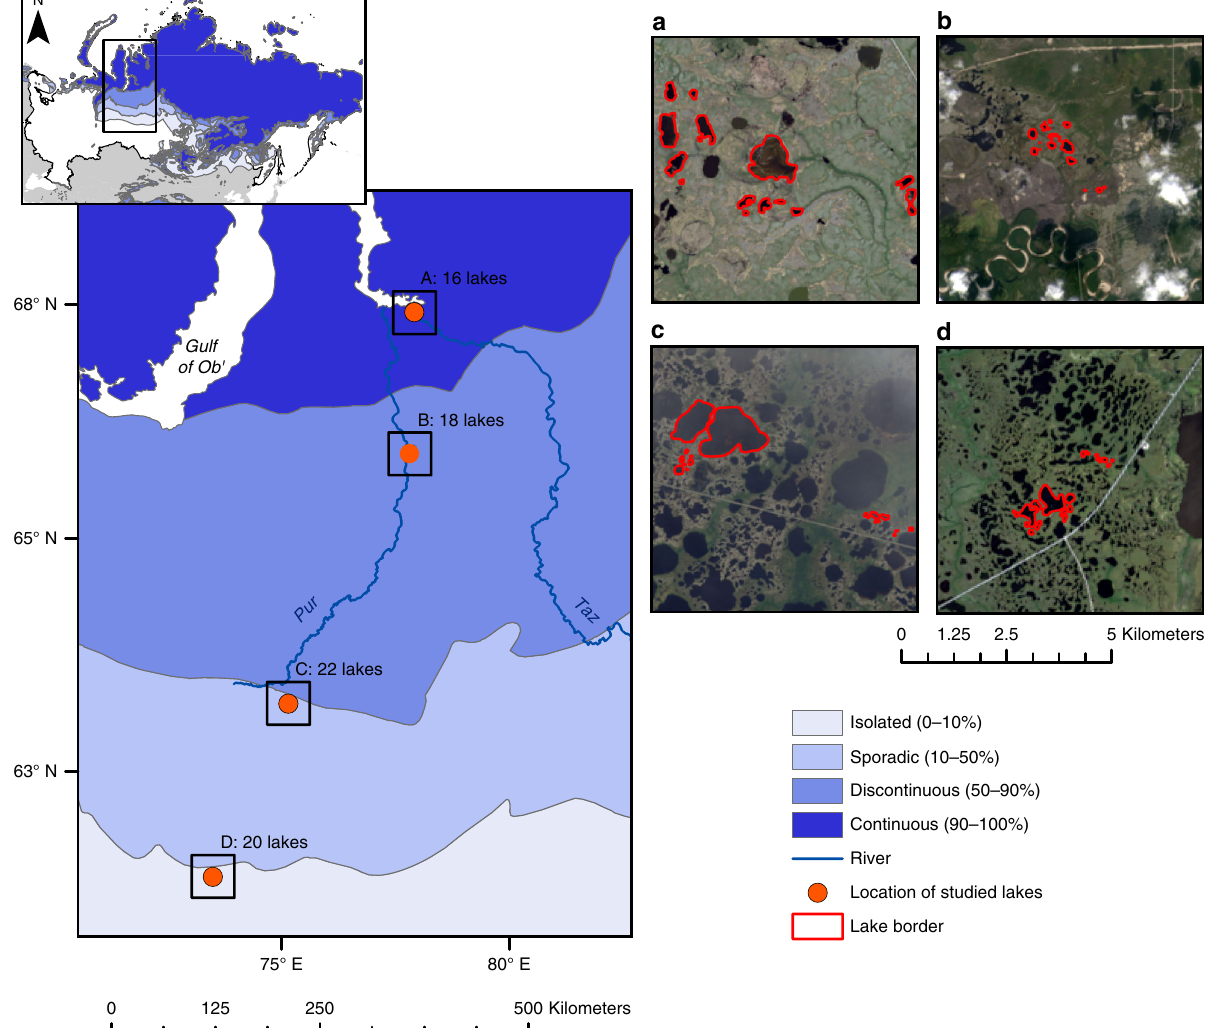
Fig. 1 Map of the study area in the Western Siberia Lowland, Russia. Blue shading represents percent permafrost extent in the area of Western Siberia Lowland based on freely-available shape fi les from Brown et al. 58 . Orange dots indicate the location of the studied sites and red lines show shorelines of the studied lakes. Panel ( a ) refers to the site in the continuous permafrost zone, panel ( b ) to the discontinuous, panel ( c ) to the sporadic permafrost zone whereas panel ( d ) to the isolated permafrost zone. For details on satellite images acquisition see Ancillary